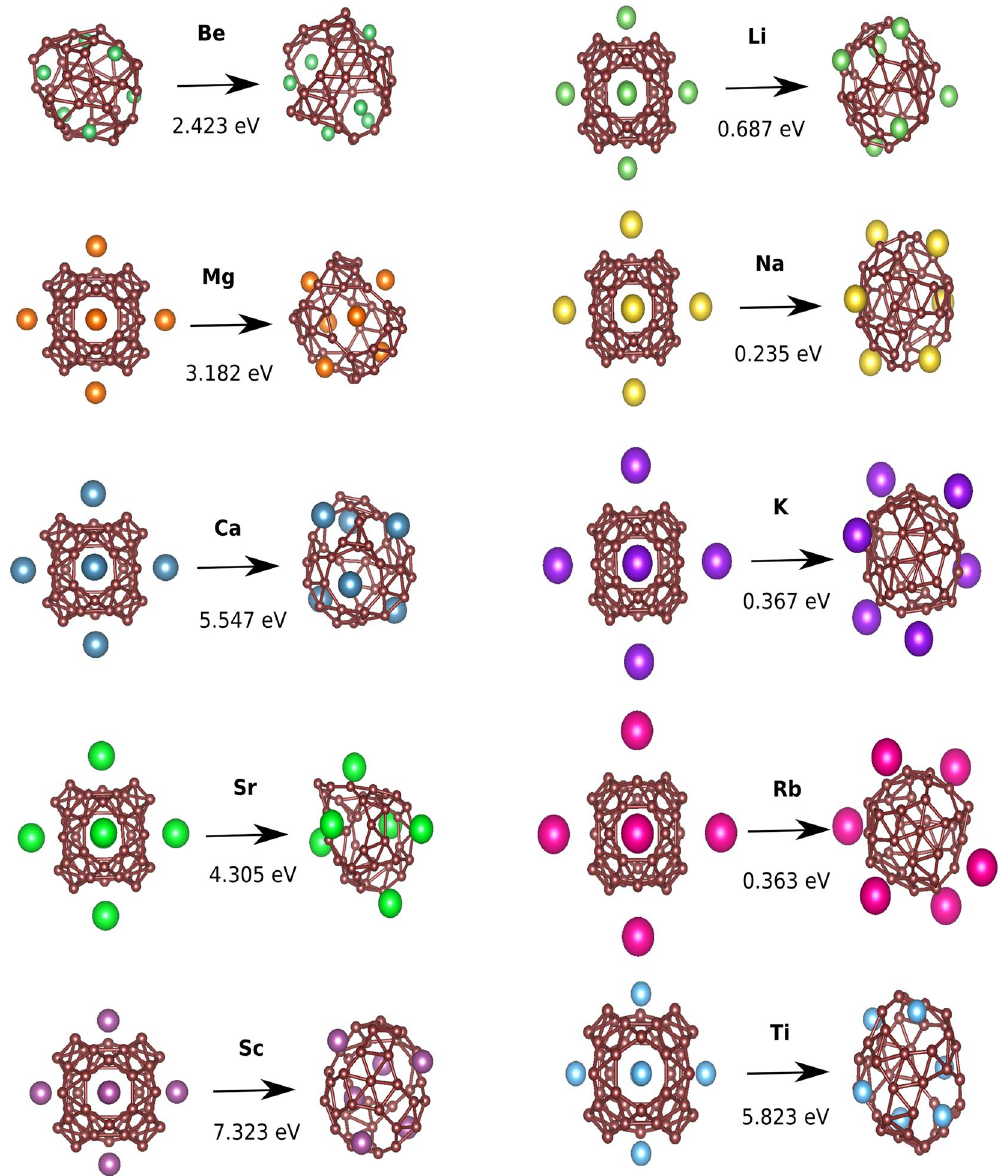
Figure 2. The first and third columns show the perfectly decorated cage structures of borospherene with different adsorbates: alkaline, earth alkaline and transition metals. The second and fourth columns represent the lowest energy structure found in minima hopping runs. Brown balls represent boron atoms and the other colours various metal atoms. The energy difference (in eV) between the lowest energy structure and the initial decorated borospherene is also shown for PBE exchange correlation